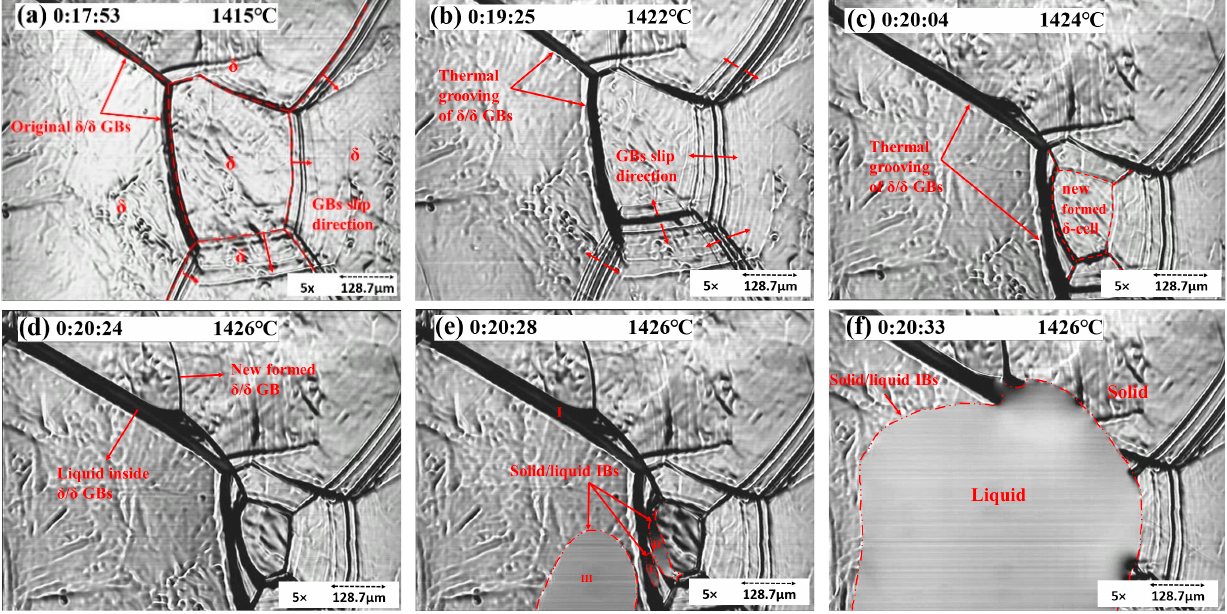
Figure 7. Concentric HTCM images revealing the δ / δ GBs enlarging and slipping ( a – c ) and S32101 DSS melting ( d – f ).